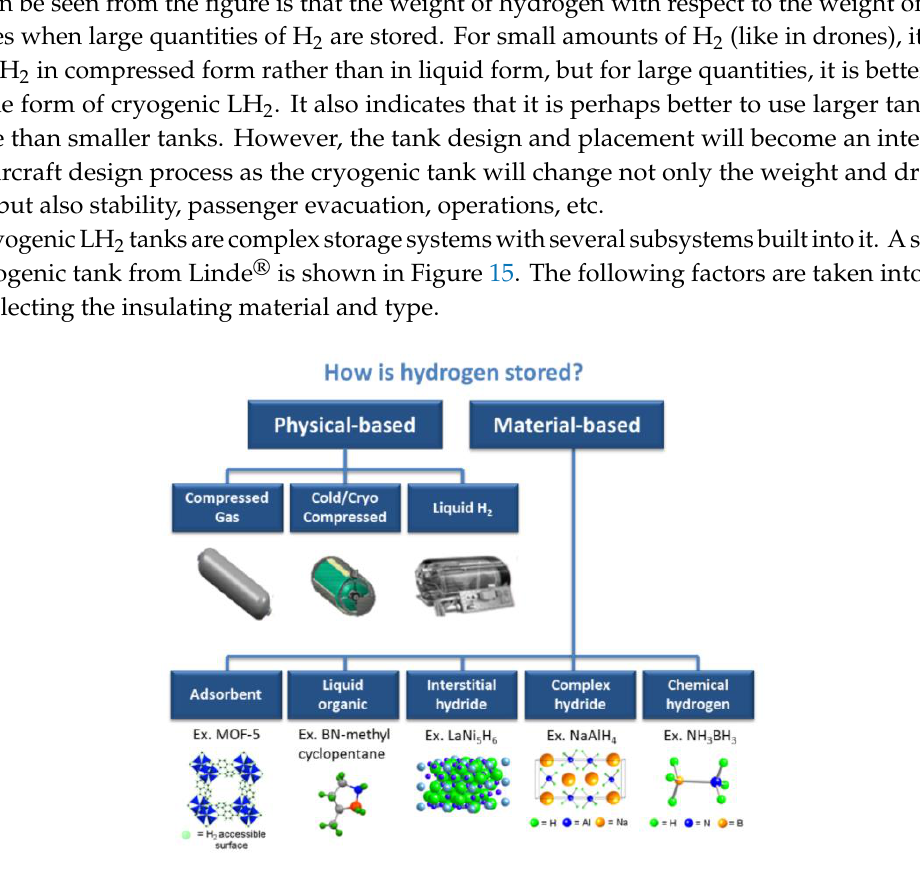
Figure 13. An overview of di ff erent hydrogen storage options (https: // www.energy.gov / eere / fuelcells /